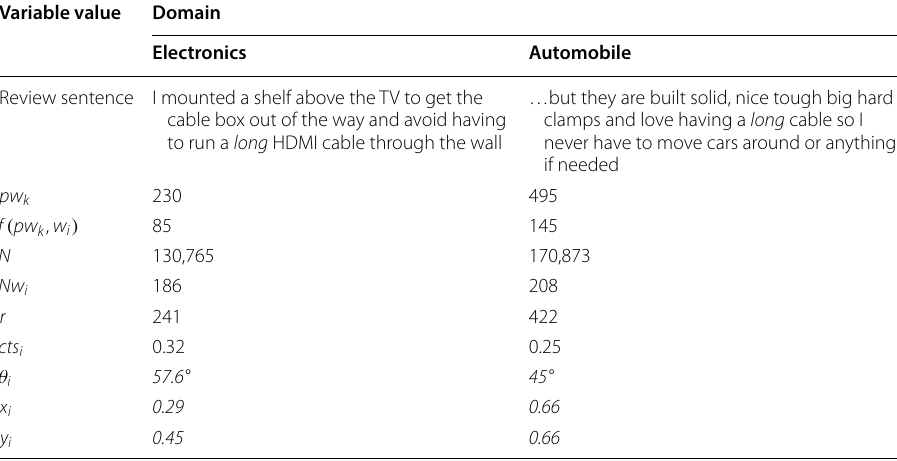
Italic values indicate Senticircle parameters calculated in both domains